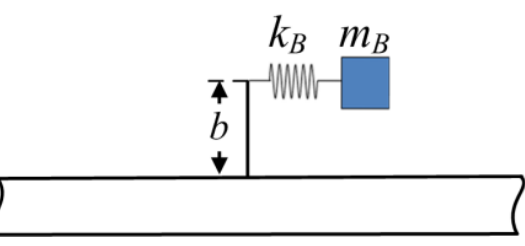
Figure 7. A host beam with a longitudinal-force-moment type resonator.